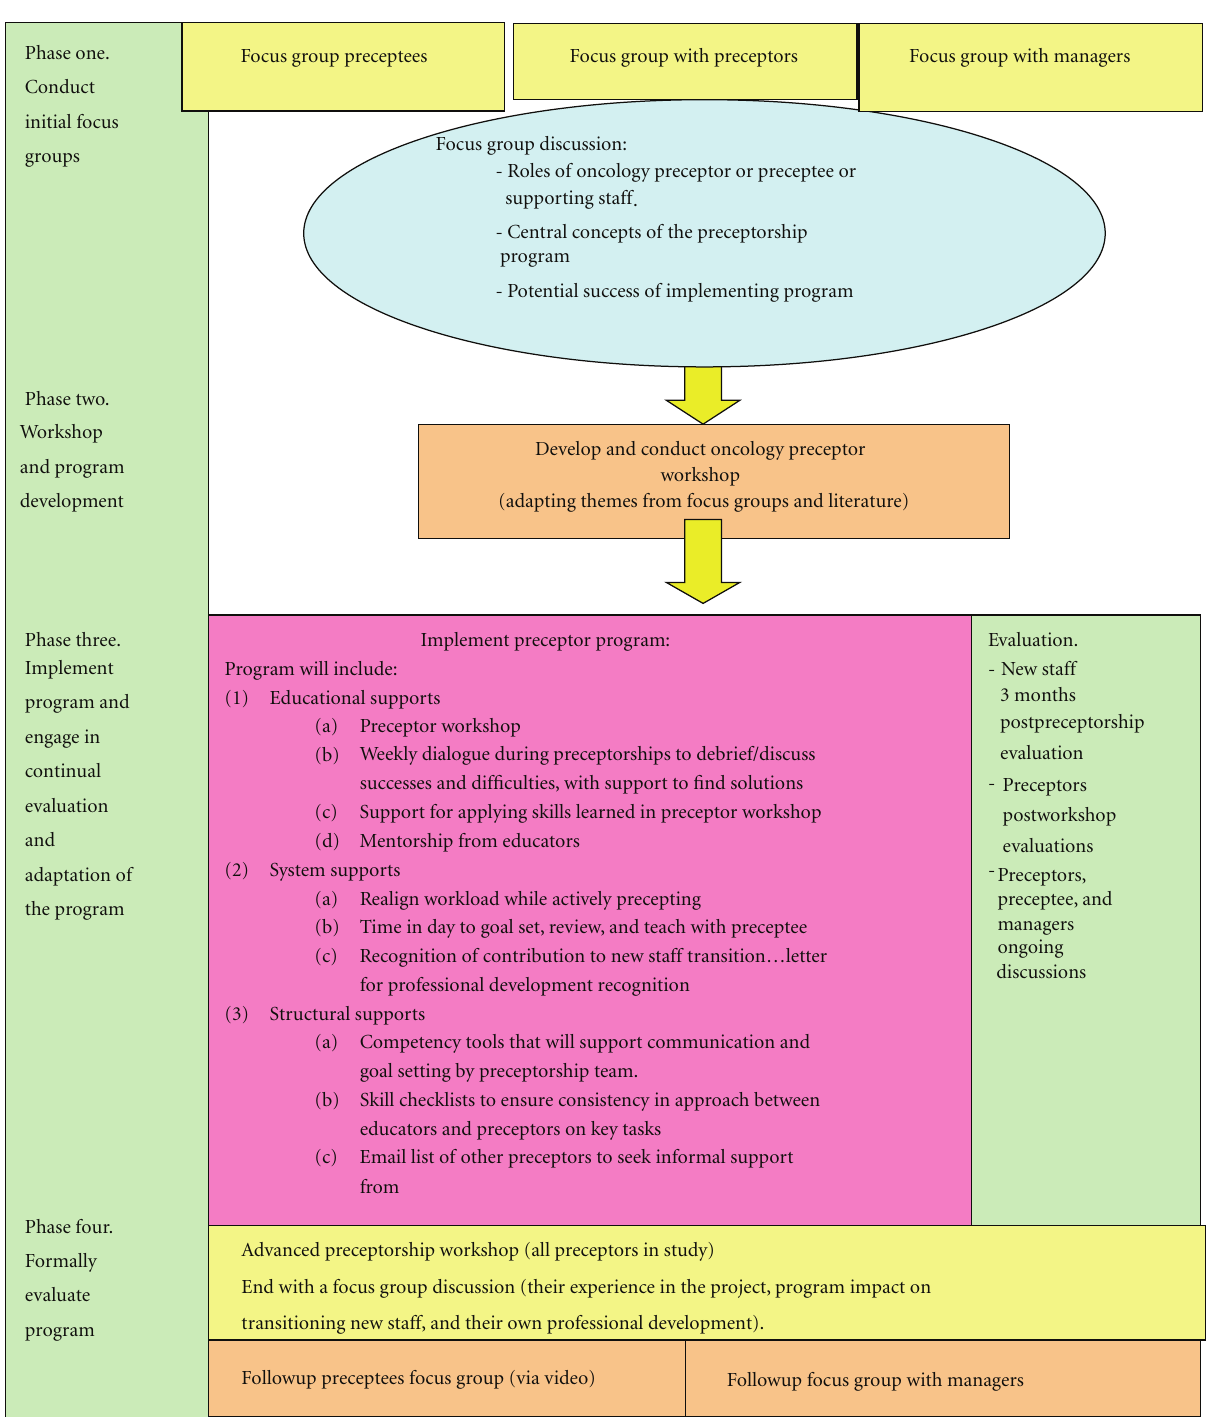
Figure 2: Schematic of ambulatory oncology peer preceptorship